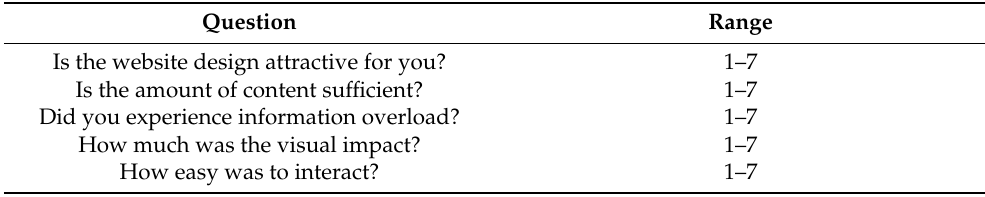
Table 1. Post-survey.